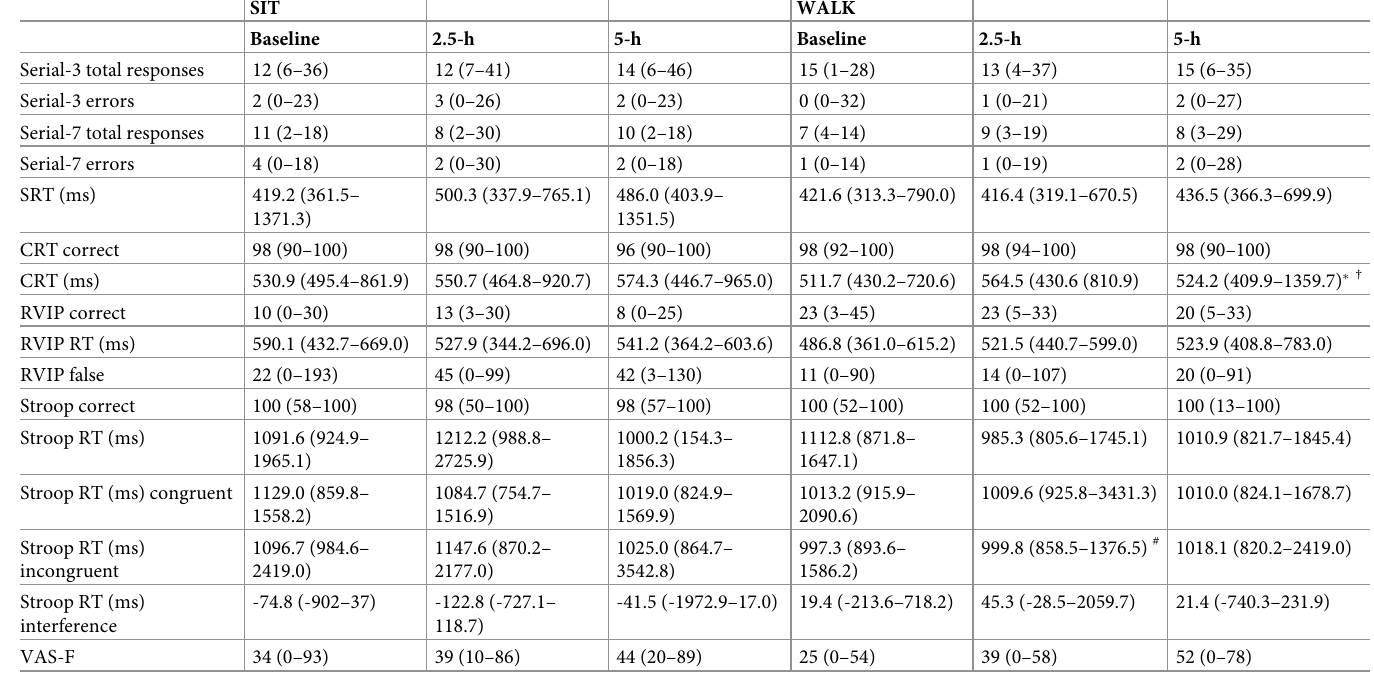
Table 4. Scores from the COMPASS cognitive tasks and VAS-F at baseline (-15-min), 2.5-h and 5-h in SIT and WALK. Data are presented as median (minimum– maximum).